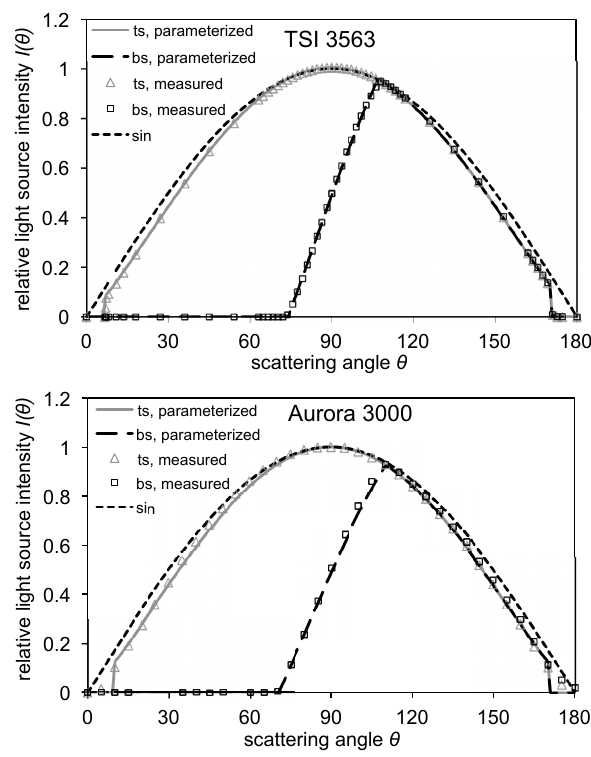
Fig. 3. Measured and parameterized angular intensity functions, f (θ) , including forward and backward truncation for the TSI 3563 (upper panel, data are taken from Anderson et al., 1996) and Au- rora 3000 (lower panel). For the Aurora 3000 the average of all three wavelengths is shown. For comparison purposes, the total scattering illumination function (ts) has been normalized to unity at 90 ◦ scattering angle. The backward scattering illumination function (bs) was adjusted to match the total scattering function at 110 ◦